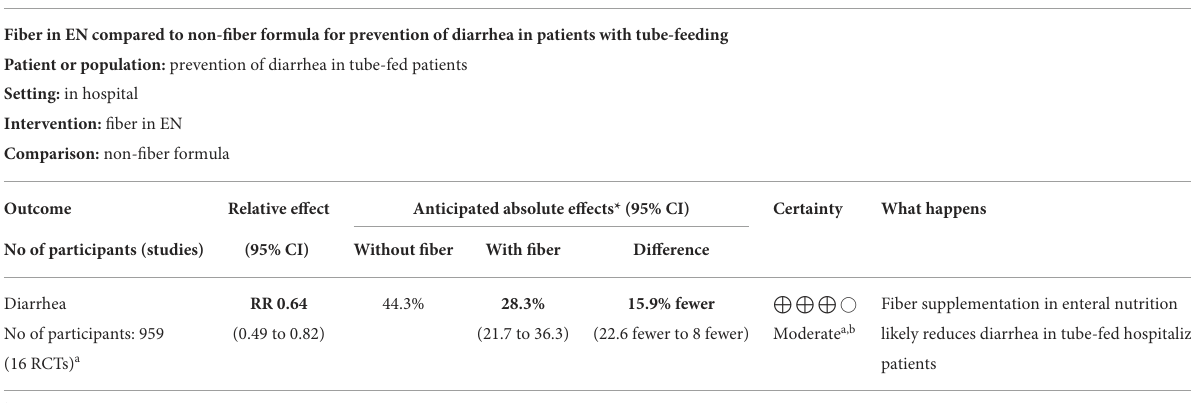
TABLE 3 Summary of findings with the grading of recommendations, assessment, development, and evaluations (GRADE) assessment. Summary of